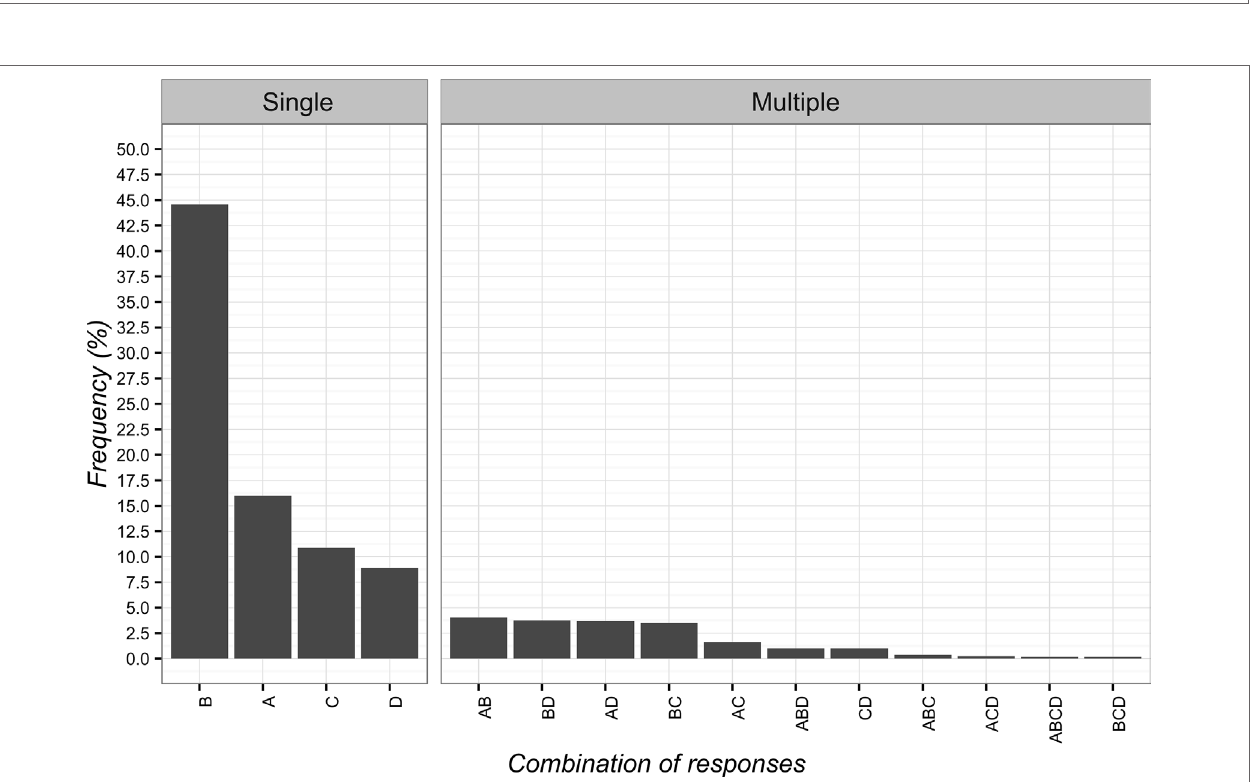
FIGURE 1 | Percentages of responses for clinical vignette 1. (A) deliver massage; (B) tell the patient that low back pain would resolve itself in a few days; (C) suggest the possibility of delivering massage if the clinical condition fails to improve; (D) advise a different treatment commonly used for low back pain; (E) try to convince the patient of the futility of the